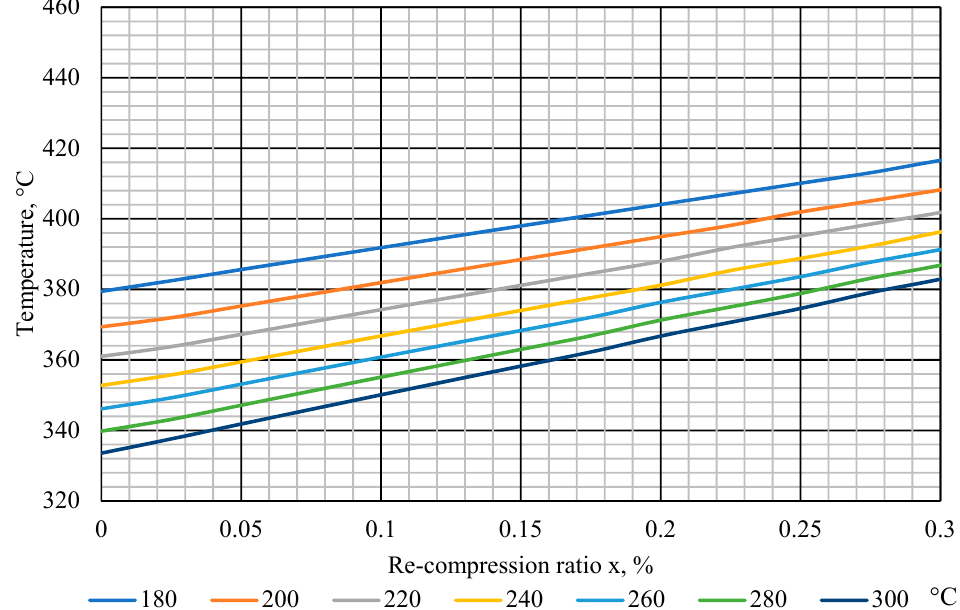
Figure 9. Dependence of exhaust gas temperature on recompression ratio and turbine inlet pressure.